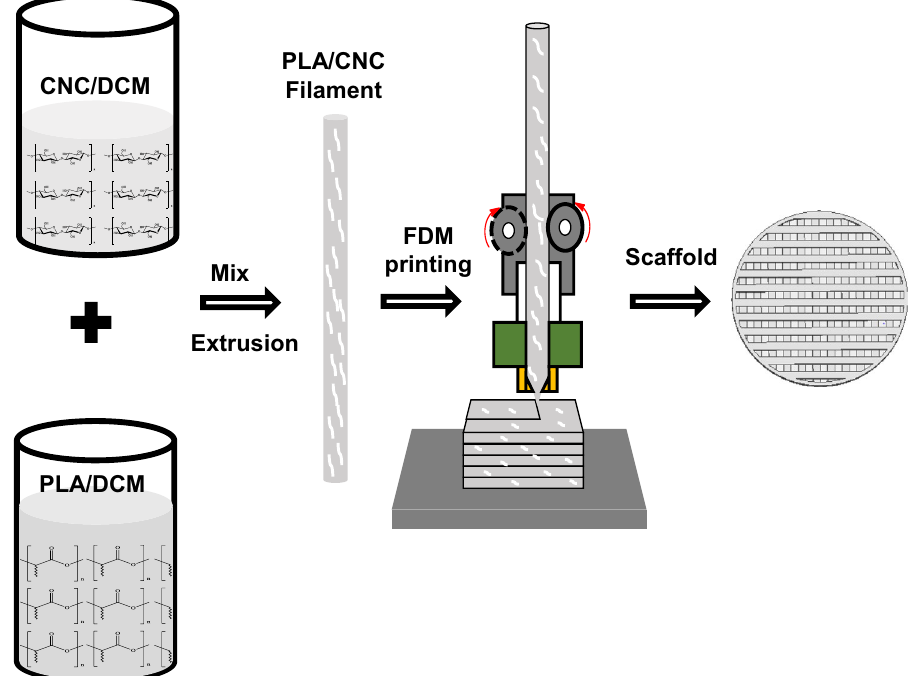
Figure 8. Fabrication steps of PLA/CNCx scaffold (extrusion of the composite filament and 3D